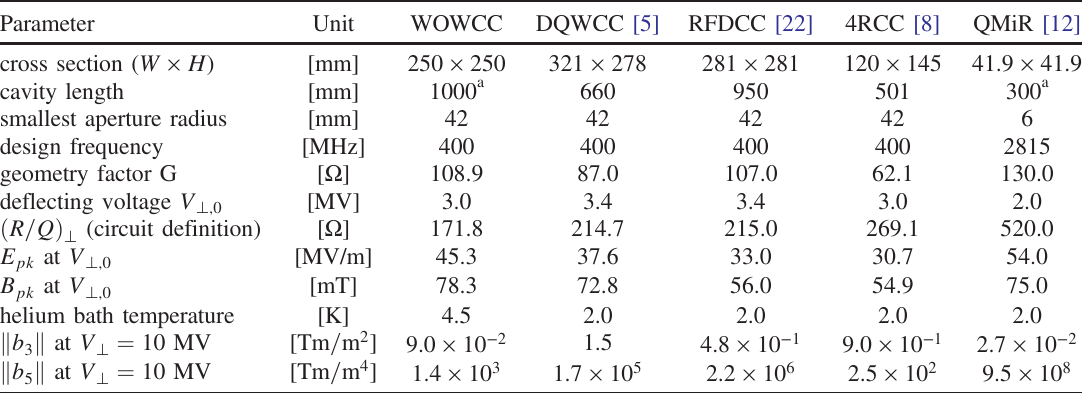
TABLE I. Main rf parameters of various rf crab cavities. Parameter